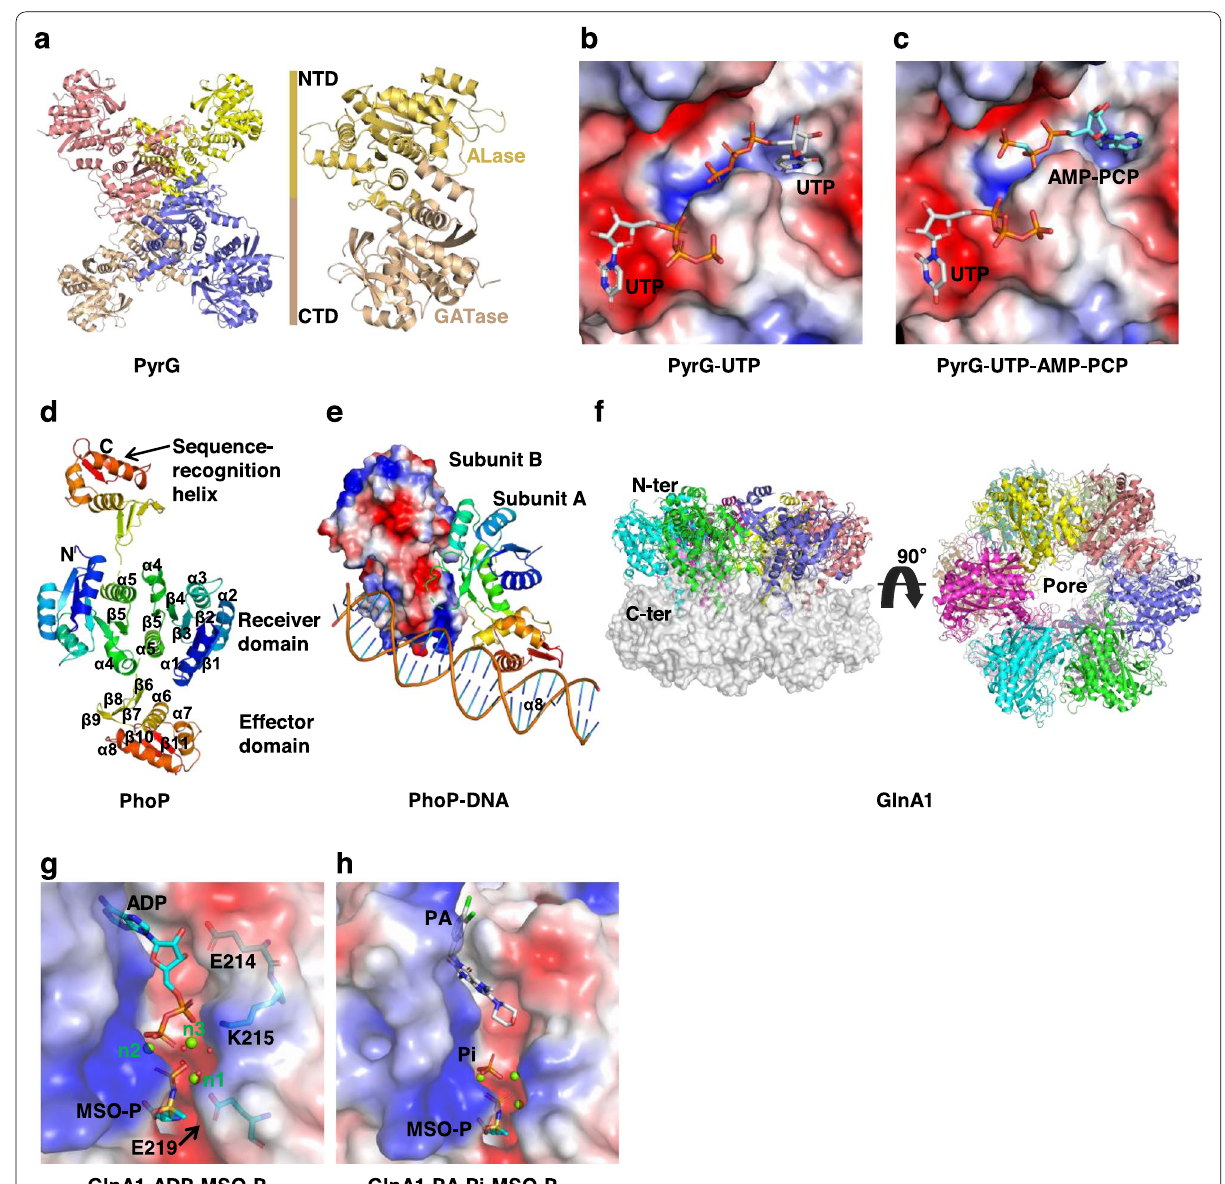
Fig. 7 Proteins associated with nucleotide biosynthesis and transcriptional regulation. a Tetrameric structure of cytidine triphosphate synthetase PyrG-apo (PDB ID: 4ZDI). The N-terminal synthetase (ALase) domain is positioned at the center of the tetramer while the C-terminal glutaminase (GATase) domain is pointing outwards. b , c Electrostatic surface of PyrG in a complex with nucleotides and analogs, i.e. either UTP or UTP/AMP-PCP. d Structure of PhoP. PhoP (PDB ID: 3R0J) dimerizes through α4-β5-α5 of the receiver domain with a 2-fold symmetry. The N- and C-termini for both subunits are marked with N and C, respectively. e Structure of PhoP-DNA complex. Ribbon diagram of the PhoP- DNA complex (PDB ID: 5ED4) shows a tandem PhoP dimer binding to a directly repeating DNA sequence. The two PhoP subunits are designated A and B, with subunit A binding to the first TCA CAG C motif that is directly repeated, while B binds to the second motif. The subunits A and B are represented by cartoon and electrostatic surfaces, respectively. f Oligomeric structure of GlnA1 (PDB ID: 1HTQ) is a double symmetric structure formed by hexamers in an asymmetric unit. Each subunit - subunit interface has 12 active sites. g Electrostatic surface of GlnA1 in a complex with MSO-P and ADP (PDB ID: 2BVC). h Electrostatic surface of GlnA1 in complex with MSO-P, PA and Pi (PDB ID: 2WHI). The electrostatic potential in all figures was computed using the APBS tools in PyMol (http:// www. pymol.